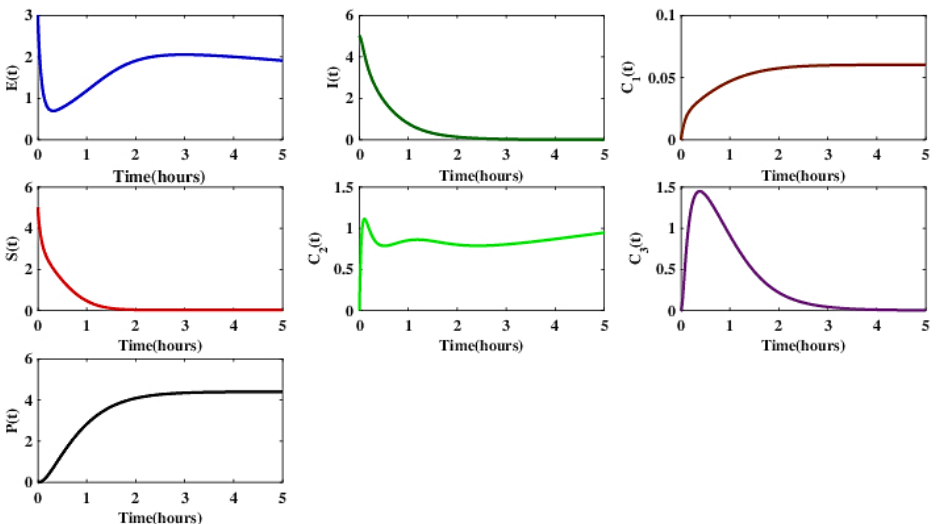
Figure 4. The nature of the curves of all reactants after alcohol consumption with the initial values 𝐸